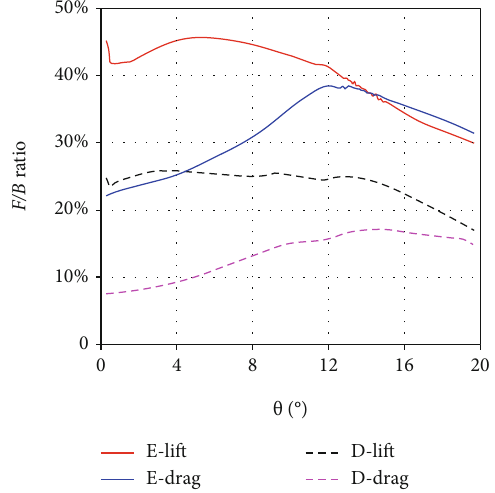
Figure 7: The F / B ratio in the erection and depression states under the quasistatic yaw